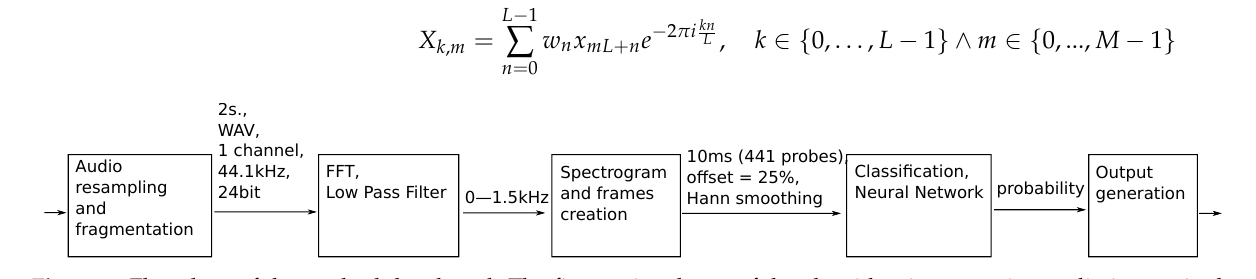
Figure 1. Flowchart of the method developed. The first optional step of the algorithm is converting audio into a single channel WAV format with 24 bit, 44.1 kHz sampling and represent it as a collection of 2-s recordings. Next, we remove the sounds outside interesting spectra using Fast Fourier Transform and Low Pass Filter. The signal is then converted into a spectrogram and the spectrogram obtained is divided into a sequence of frames. Finally, every frame (spectrogram) is classified using machine learning algorithms, with the returning binary value representing the frame as either bowel sound or noise. We calculate the output from adjacent